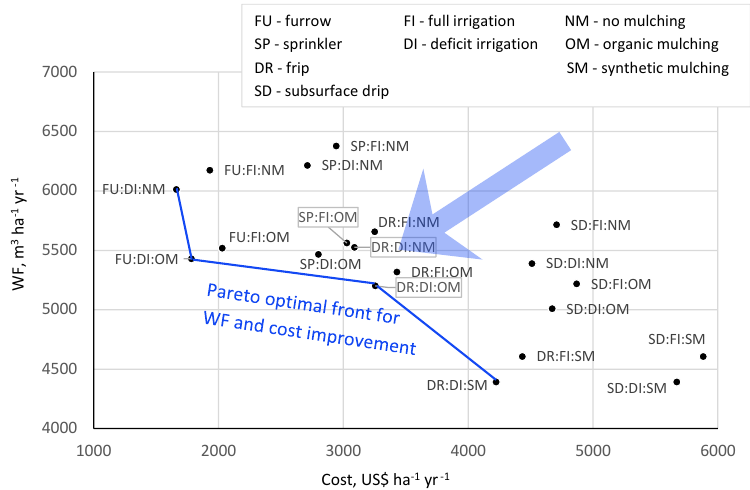
Figure 5. Pareto optimal front for WF and cost reduction in irrigated crop production. The dots represent the annual cost of maize production and the WF per area for 20 management packages. The line connects the Pareto optimal management packages.